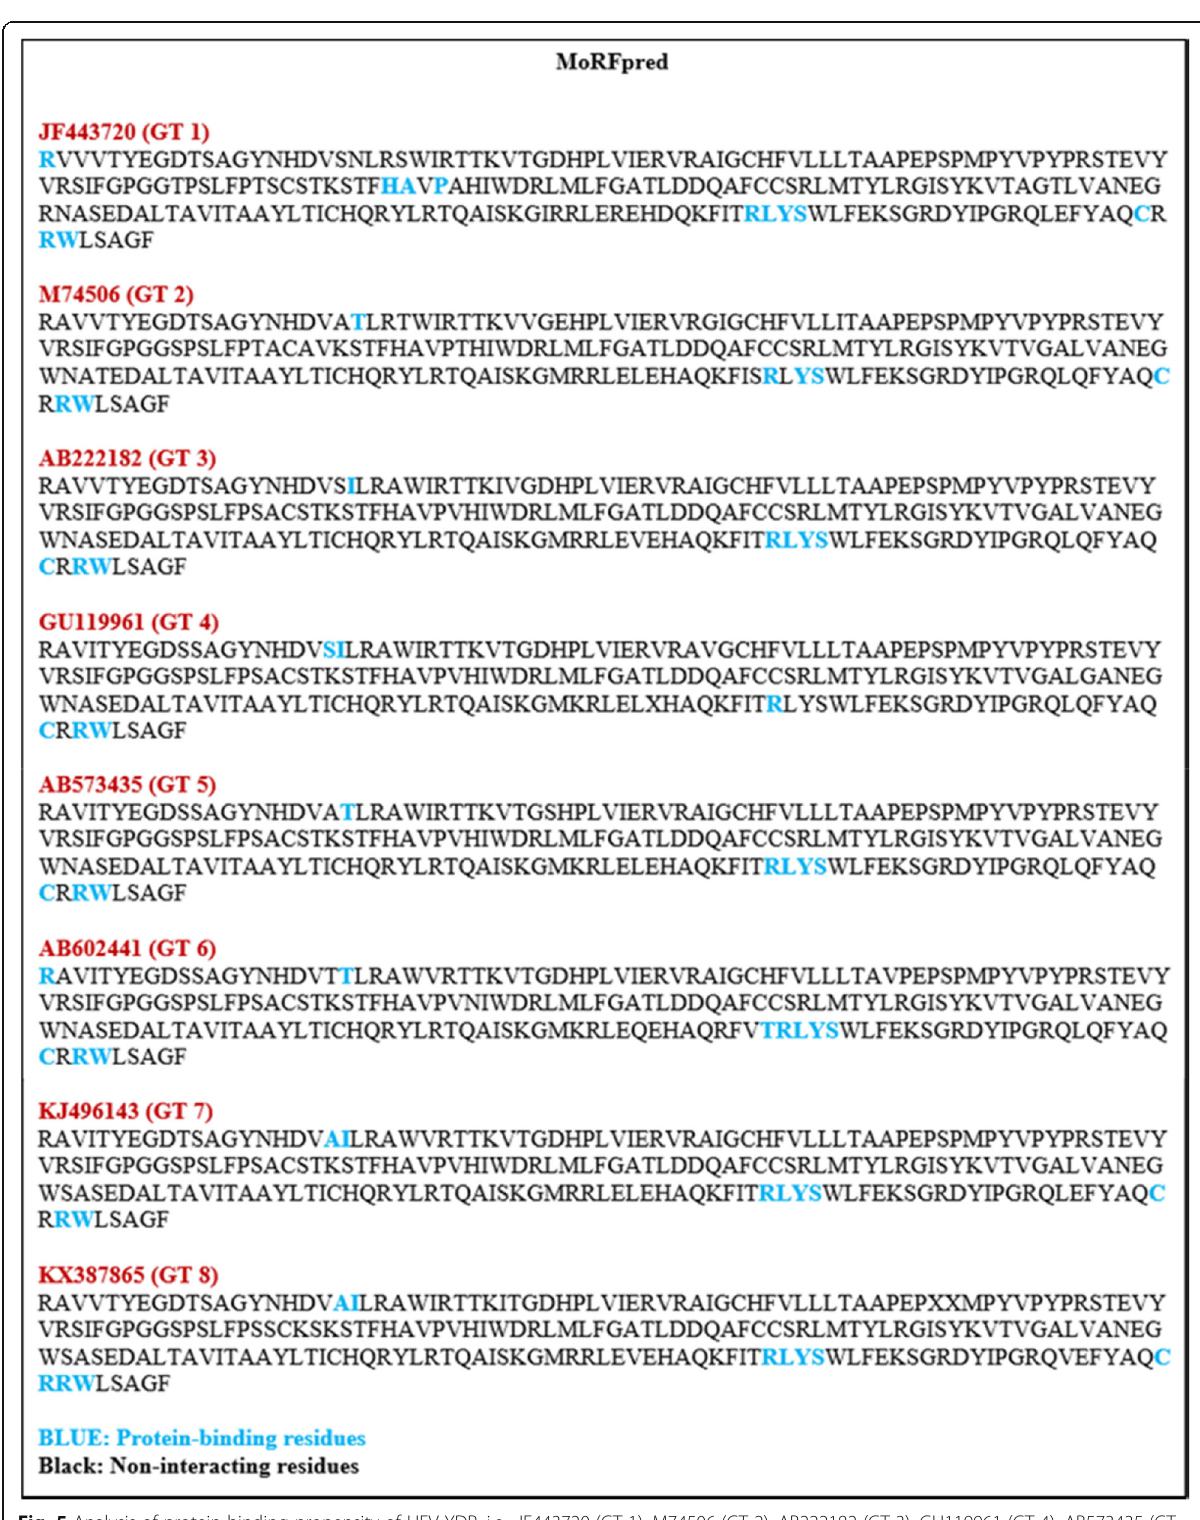
Fig. 5 Analysis of protein-binding propensity of HEV YDR, i.e., JF443720 (GT 1), M74506 (GT 2), AB222182 (GT 3), GU119961 (GT 4), AB573435 (GT 5), AB602441 (GT 6), KJ496143 (GT 7), and KX387865 (GT 8). The resulting protein-binding profile was calculated using MoRFpred. YDR mainly contains MoRFs at C-terminals. The protein-binding residues are depicted in blue while the non-interacting residues are depicted in